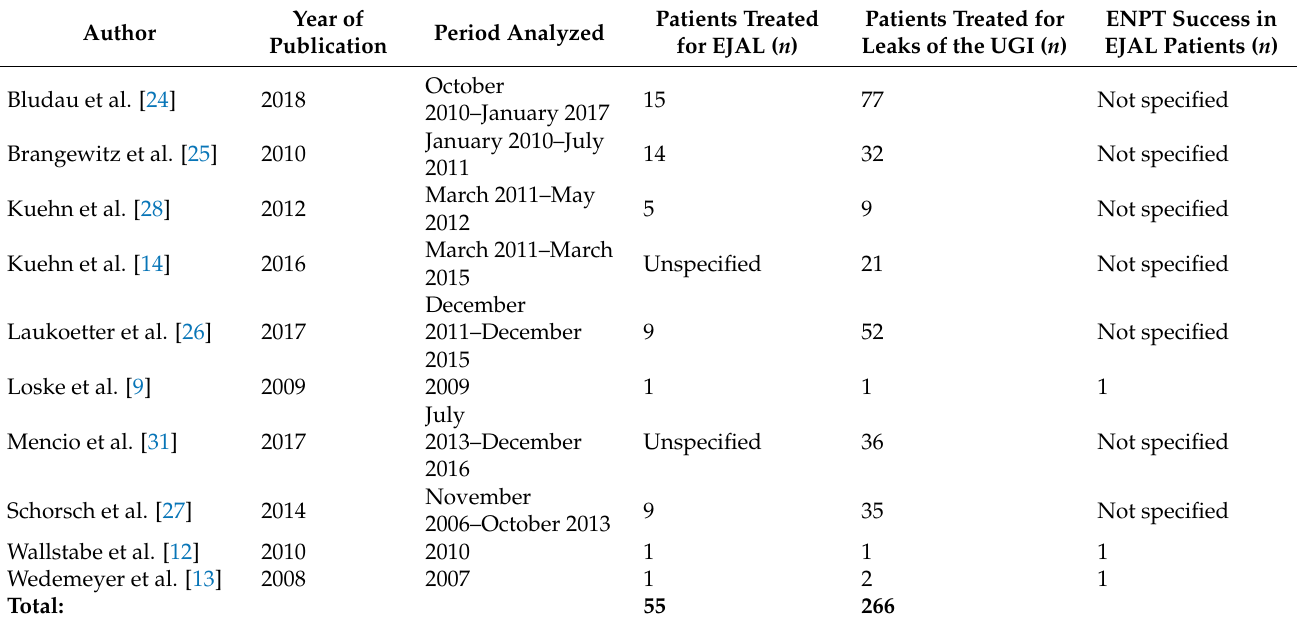
Table 3. Literature review focused on ENPT for